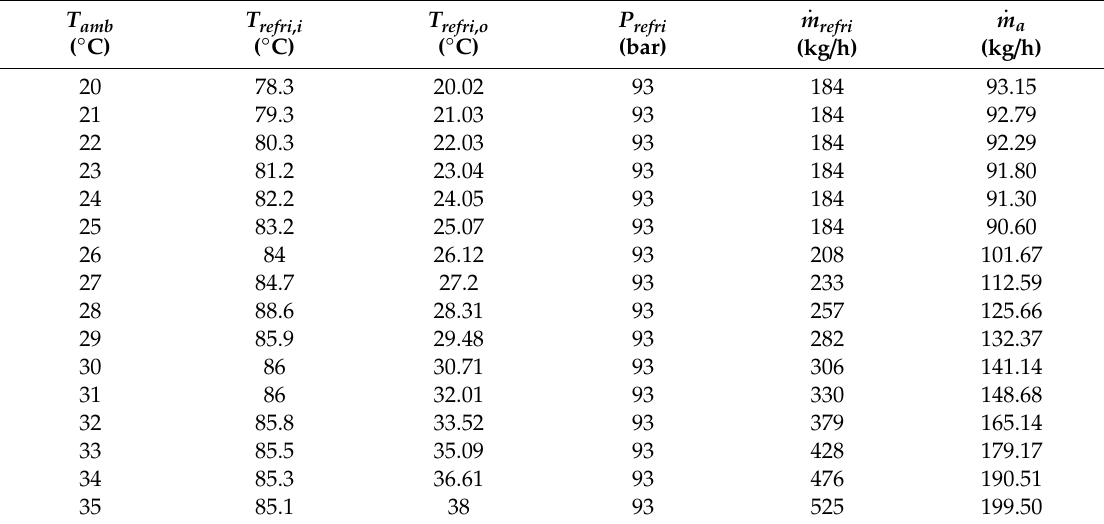
Table 3. O ff -design boundary